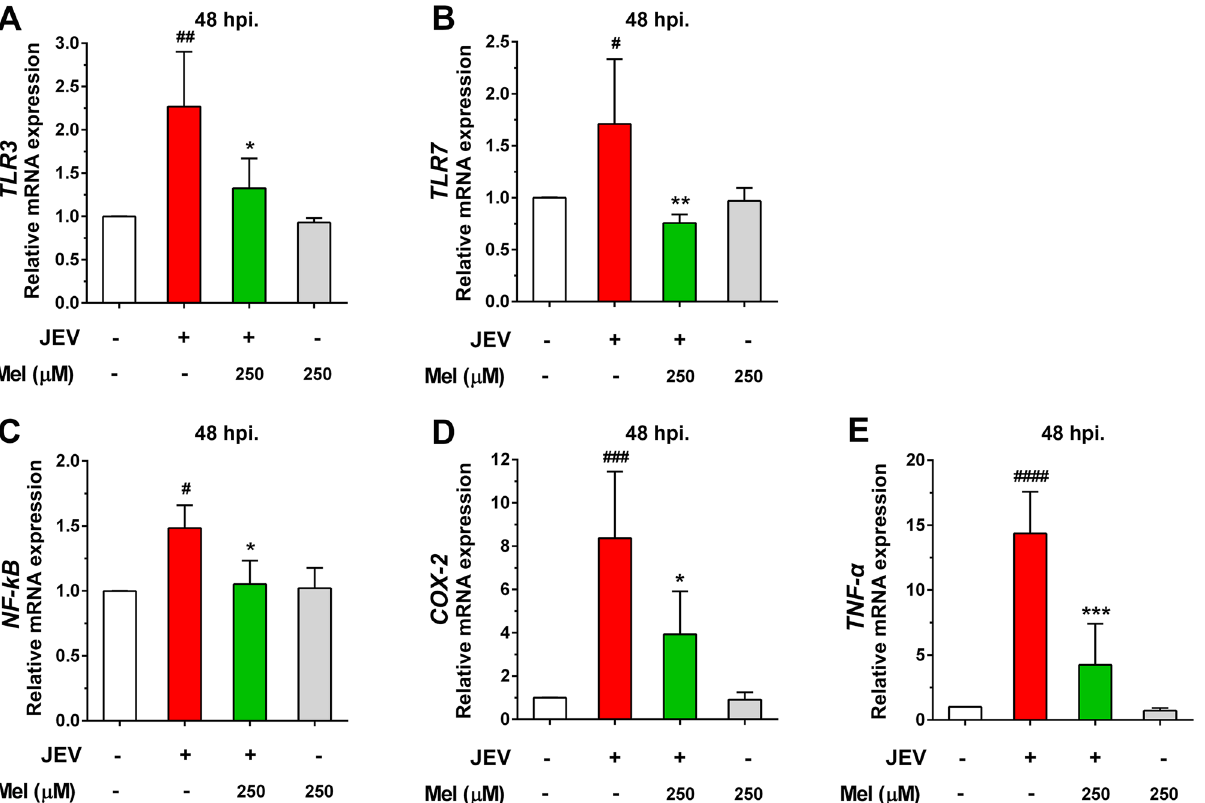
Figure 7. The effect of melatonin (Mel) on inflammation-related genes in JEV-infected SH-SY5Y cells. Cells were pre-treated with melatonin at various concentrations and infected with 0.1 MOI of JEV. The cells were maintained in melatonin for 24 or 48 h. The infected cells were collected to determine mRNA expression by qPCR. ( A ) TLR3 , ( B ) TLR7 , ( C ) NF-κB , ( D ) COX-2 , and ( E ) TNF-α. The graphs show the means ± SD of three independent experiments. One-way ANOVA and Tukey–Kramer multiple comparisons tests were performed for statistical analysis. # p < 0.05, ## p < 0.01, ### p < 0.001, and ### p < 0.0001 compared to the cell control. * p < 0.05, ** p < 0.01, and *** p < 0.001 compared with the JEV-infected